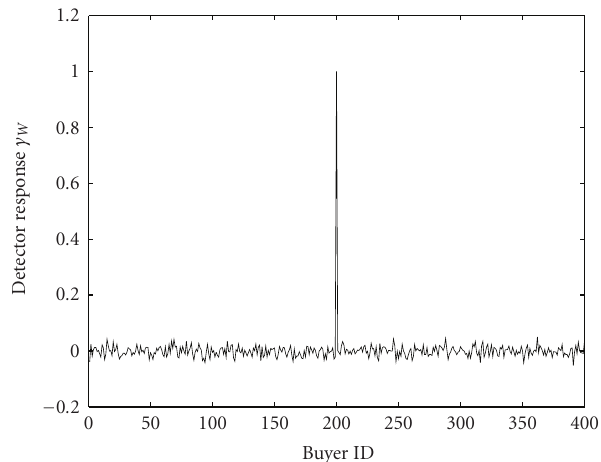
Figure 5: Identifying the malicious buyer by the WCA. The WCA traces the traitor with the watermark W according to (4).